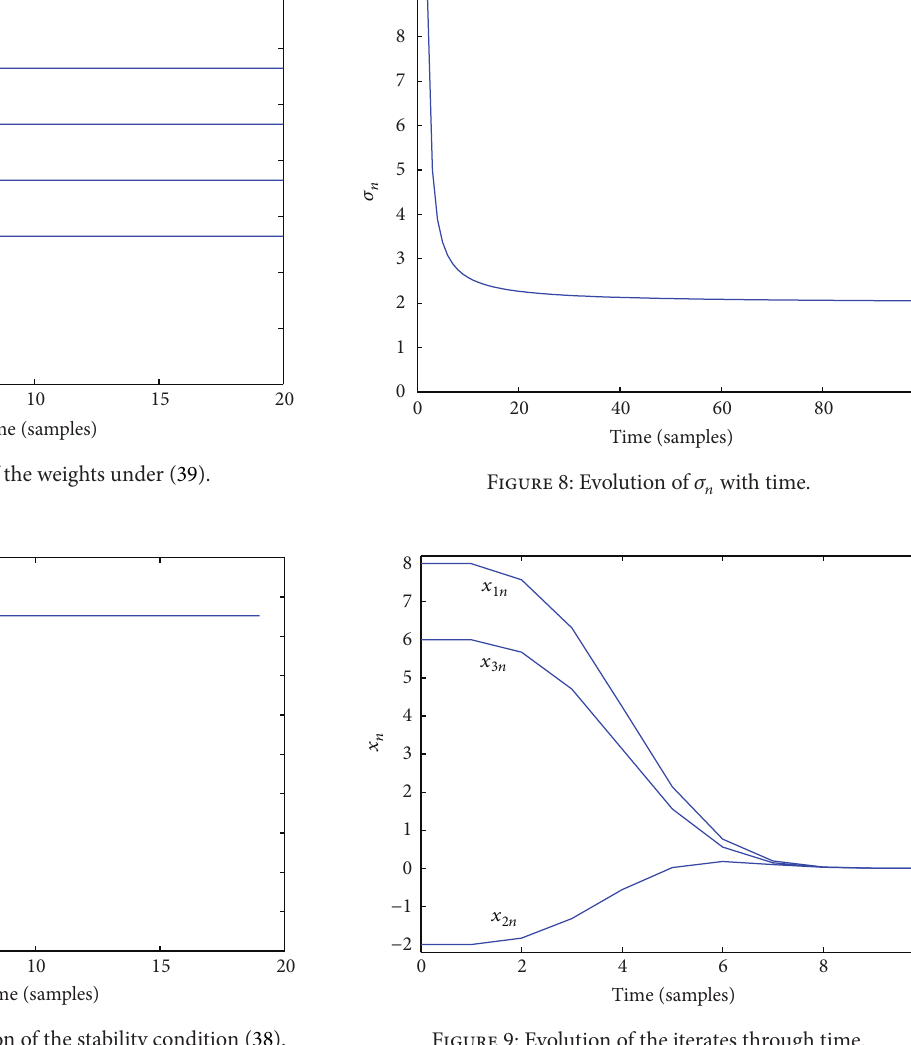
Figure 9: Evolution of the iterates through